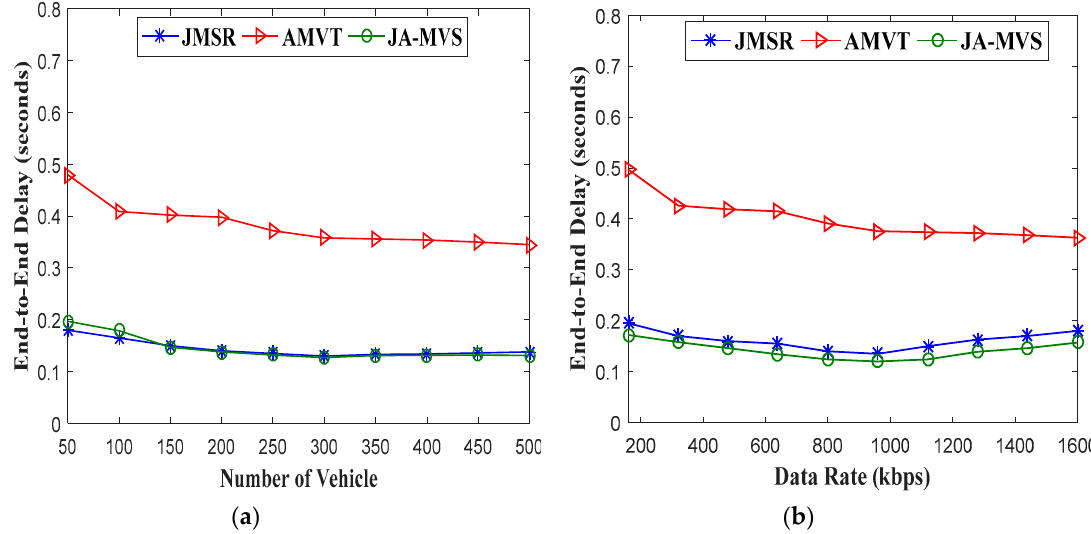
Figure 7. End-to-End Delay based on ( a ) varied numbers of vehicles and ( b ) data rates.